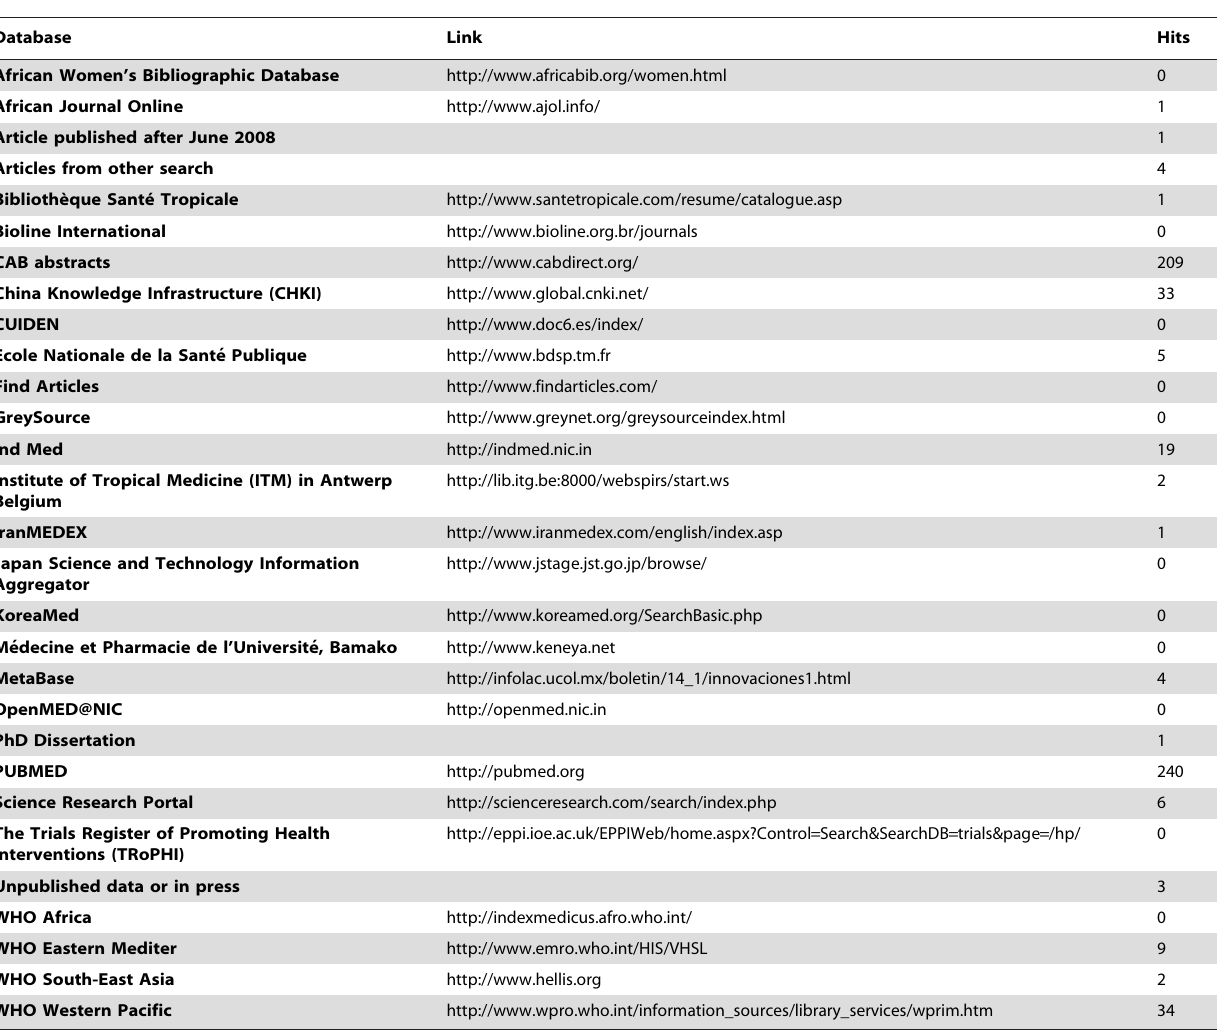
Table 1. Results of search strategies on neurocysticercosis epidemiology published between 1990 and 2008